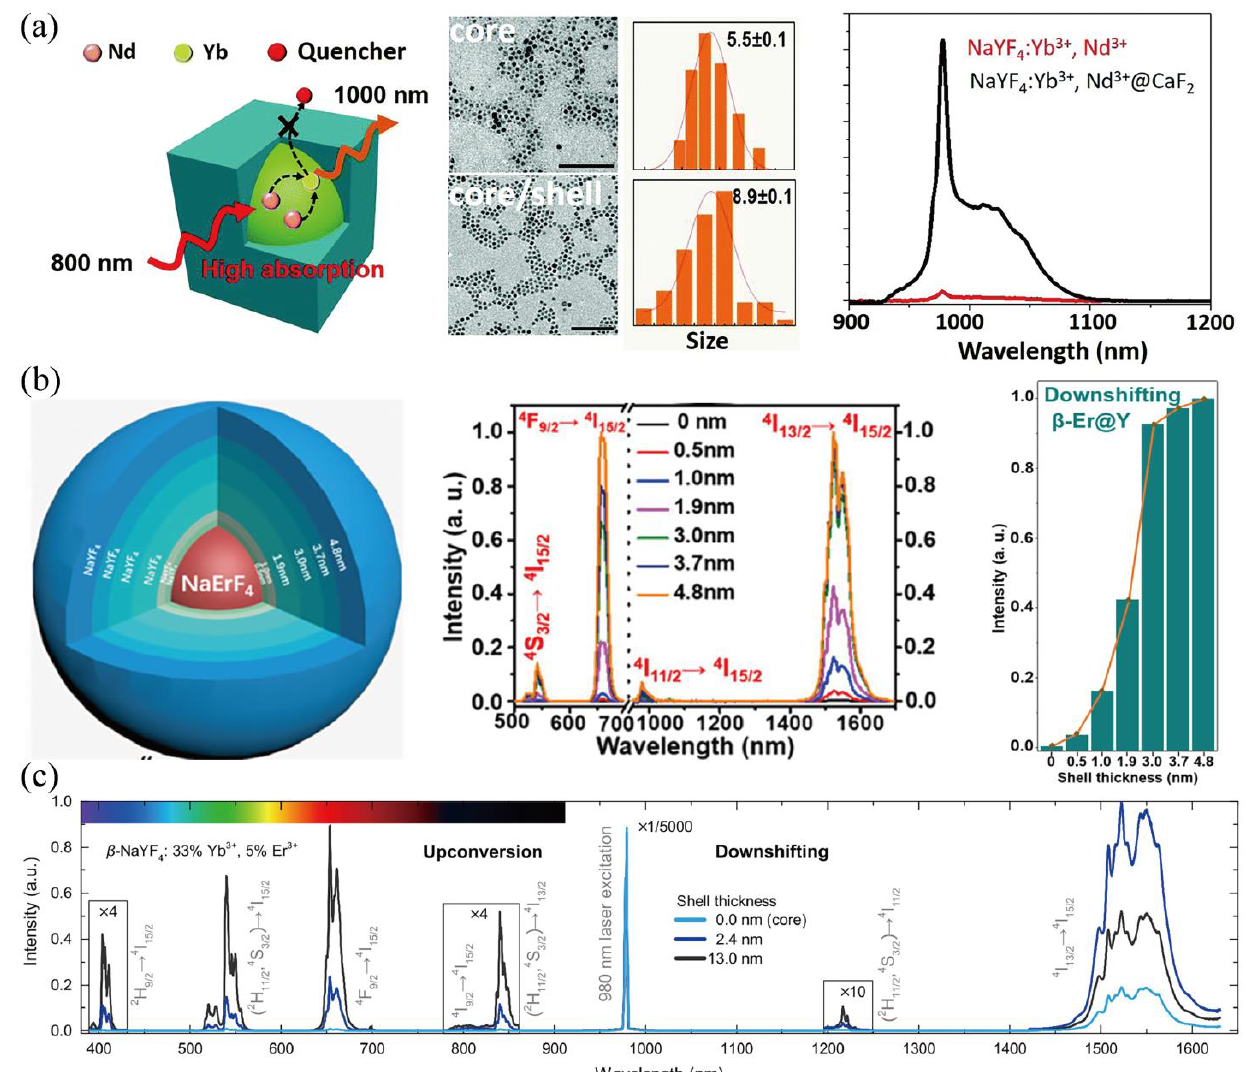
Figure 4. ( a ) Schematic illustration, TEM image and emission spectra of the core and core@shell. Adapted, with permission, from Ref. [48]. Copyright 2018, Royal Society of Chemistry. ( b ) Schematic illustration, NIR−II spectra and intensity of β -NaErF 4 @NaYF 4 . Adapted, with permission, from Ref. [49]. Copyright 2020, American Chemical Society. ( c ) NIR−II luminescence of NaYF 4 : Yb 3+ , Er 3+